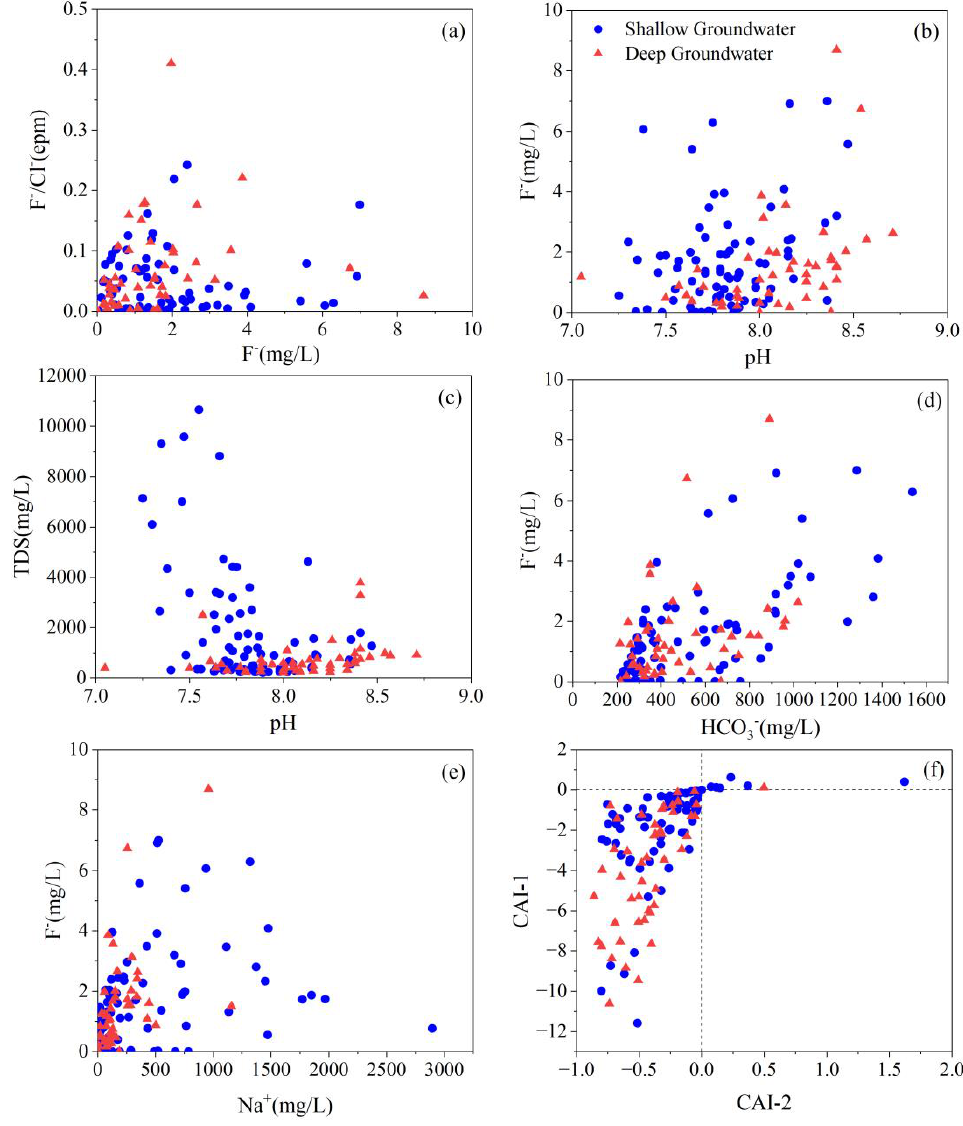
Figure 8. Scatter plots of ( a ). F − vs.F − /Cl − (epm); ( b ). pH vs. F − ; ( c ). pH vs. TDS; ( d ). HCO 3 − vs. F − ; ( e ). Na + vs. F − ; ( f ). CAI-2 vs. CAI-1 − . The relationship between Cl − and δ 18 O can indicate the fractionation process of vari- ous isotopes during groundwater transport [52]. There are three trends in the relationship between Cl − concentration and δ 18 O in groundwater in the study area (Figure 7b): (1) The δ 18 O increased sharply, whereas the Cl − concentration hardly changed. This reflects fast recharge by irrigation returns and mixing with shallow water because both are associated with different δ 18 O values.; (2) There is a significant correlation between δ 18 O and Cl − concentration, and δ 18 O tends to enrich with the increase in Cl − concentration, indicating that the groundwater is affected by evaporation. (3) The trend slope of Cl − is smaller than that of evaporation, and the concentration of Cl − is high, which should be resulted from halite dissolution. Part of the samples in Figure 8b are located around trend line 2, confirming the influence of evaporation, but most of the samples are located near